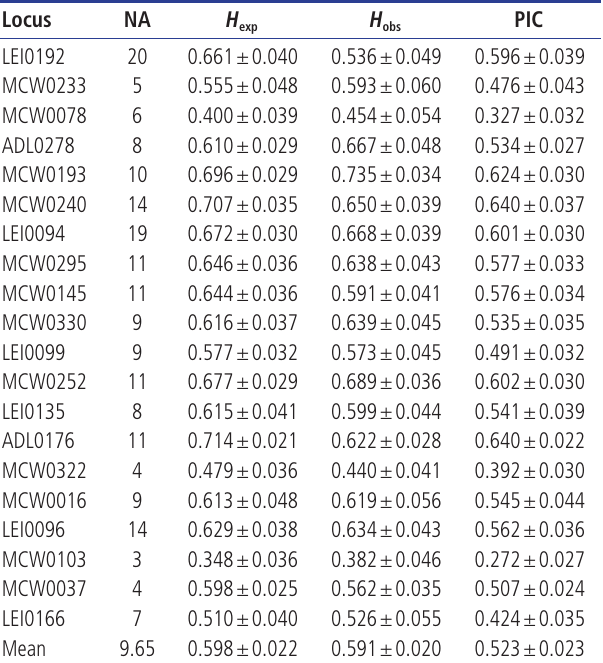
Table 2. The statistical analysis of heterozygosity and polymorphism information content using 20 microsatellite markers Locus